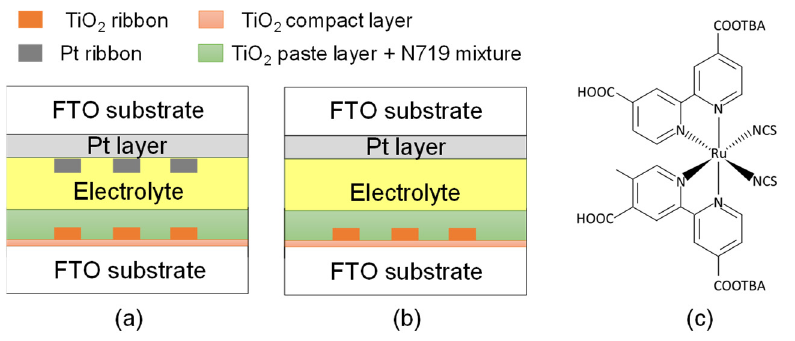
Figure 2. Configuration of DSSCs ( a ) with and ( b ) without a Pt ribbon. ( c ) Structure of D719 dye. The amount of D719 dye adsorbed on the TiO 2 paste layers of the DSSCs with and without the Pt ribbon were measured by ultraviolet-visible spectrometry [13]. The experi- mental results revealed that D719 dye has an identical adsorption amount of 0.34 mM in the DSSCs with and without the Pt ribbon, which is 69% of the concentration of the N719 mixture. The identical adsorption amount arises because the photoelectrodes are the same in the DSSCs with and without the Pt ribbon.